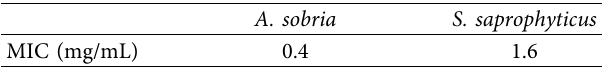
Table 1: Te MICs of A. sobria and S. saprophyticus after KA